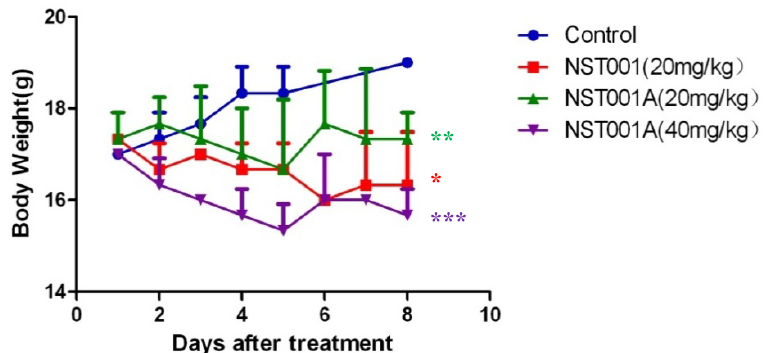
Figure 5. Effects of different drug loaded system on the body weight of nude mice.